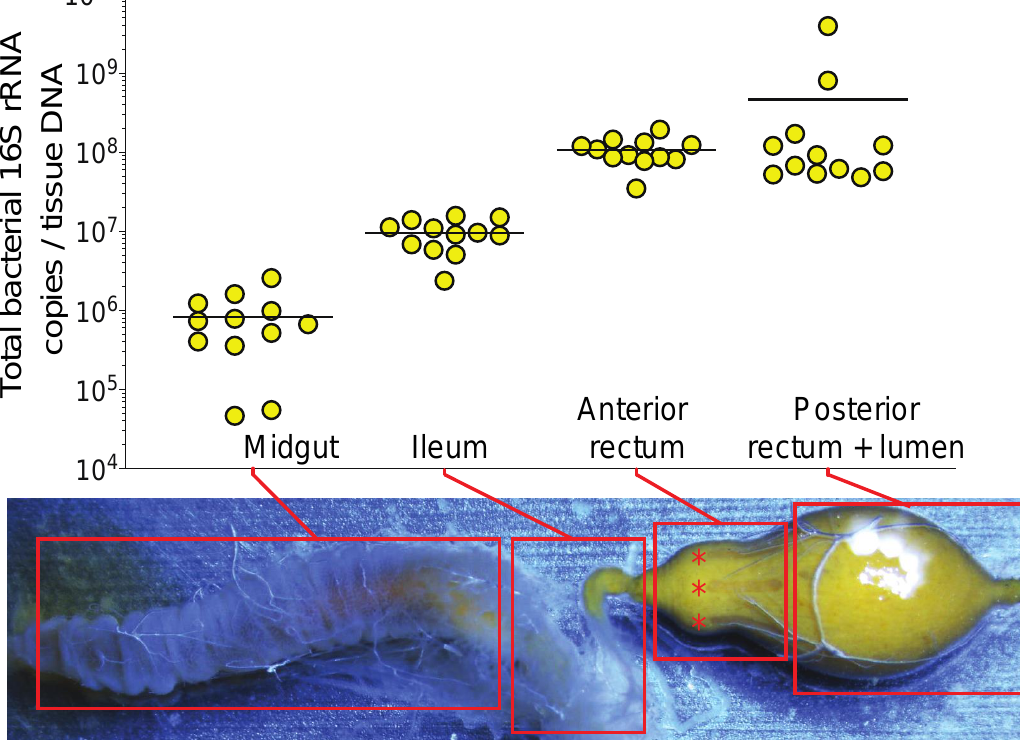
Figure 1. Quantification of bacterial 16S abundance in honey bee gut tissue total DNA extracts. The rectum was subsectioned into the rectal-pad containing the anterior portion and the posterior portion plus lumen contents. The anterior rectum was washed to remove the bacterial signal from the lumen. Each point represents the average 16S copies from a pool of 12 nurse-aged bees from a distinct colony ( n = 12 colonies). Horizontal black lines represent the mean. Rectal pads are marked with asterisks *.